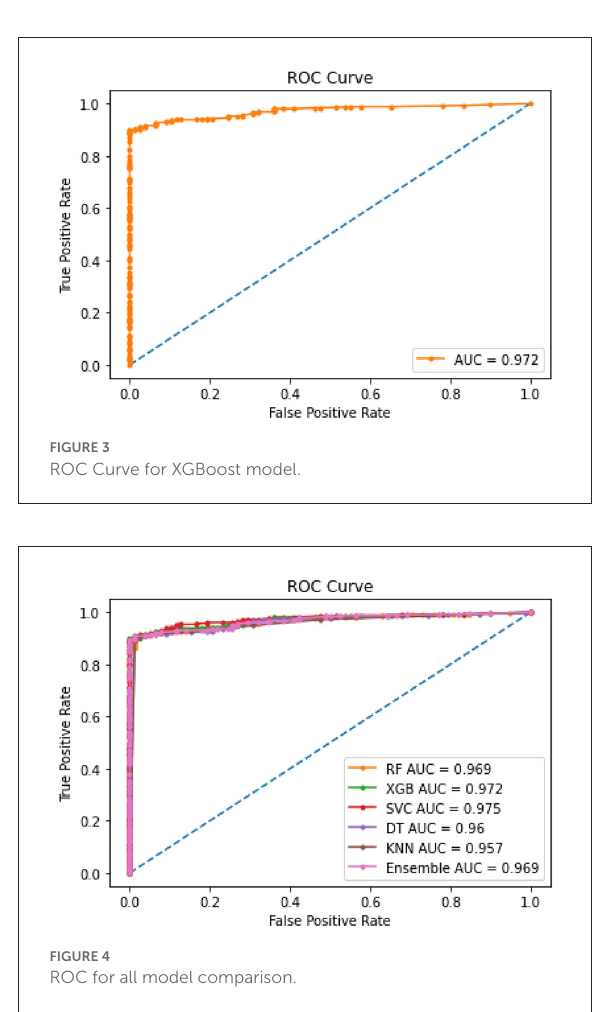
TABLE 5 ROC-AUC scores for XGBoost.